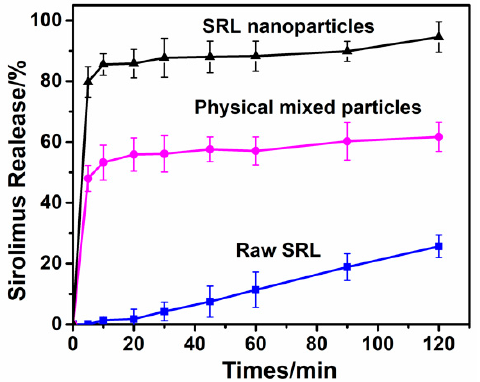
Figure 10. Dissolution profiles of raw SRL, physical mixed particles and SRL nanoparticles.